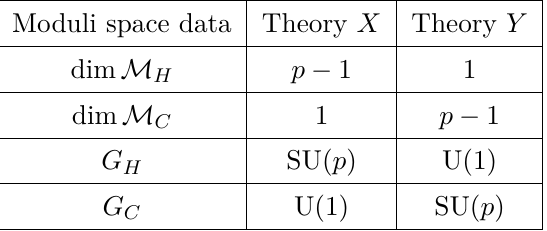
Table 9 . Summary table for the moduli space dimensions and global symmetries for the mirror pair in figure 33.